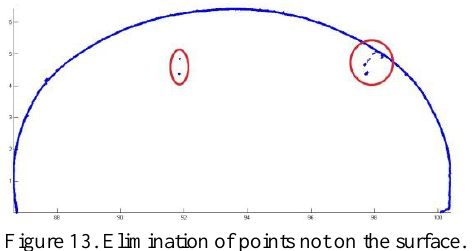
Figure 13. Elimination of points not on the surface.